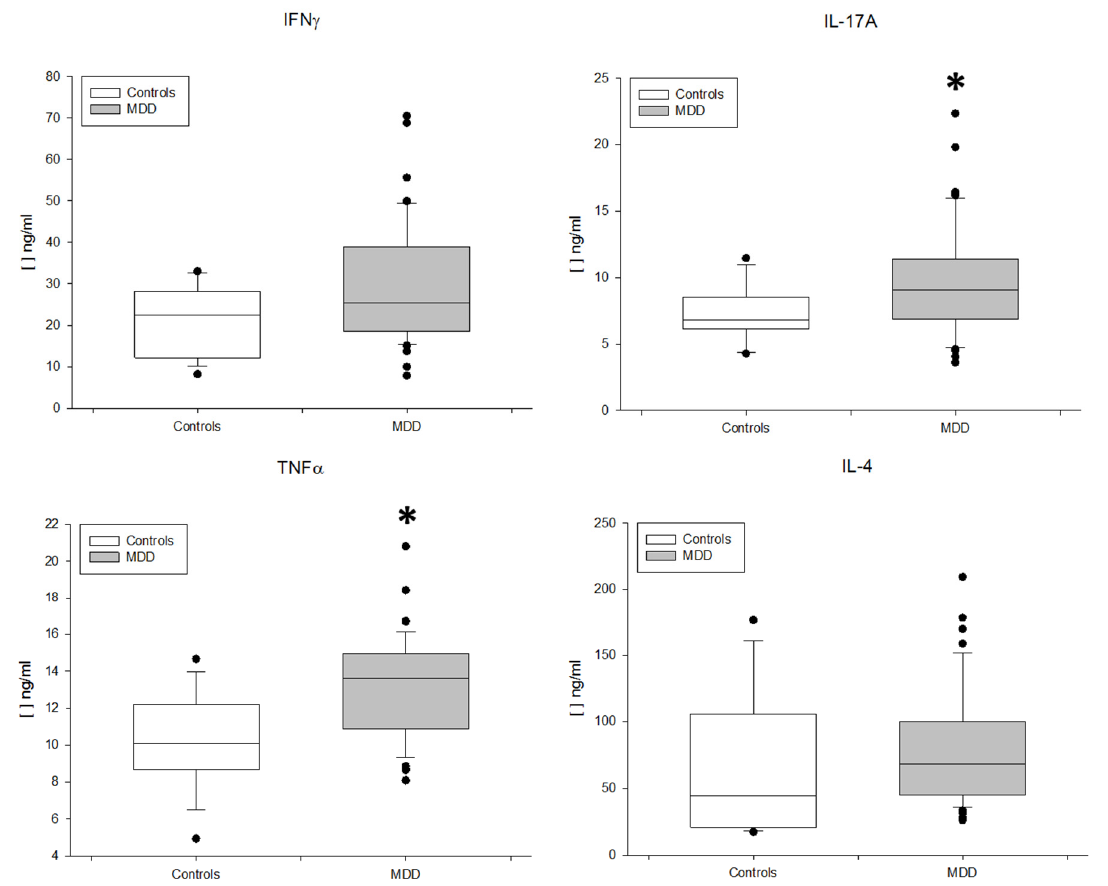
Figure 5. Circulating serum levels of IL-17A, IFN γ , TNF-alpha and IL-4 in MDD patients (black rectangles plots) and HCs (gray rectangles plots). Serum concentrations (pg/ µ L) (y axis) of IFN γ , IL-17A, IL-4 and TNF-alpha. * Significant difference between MDD and HCs for the indicated